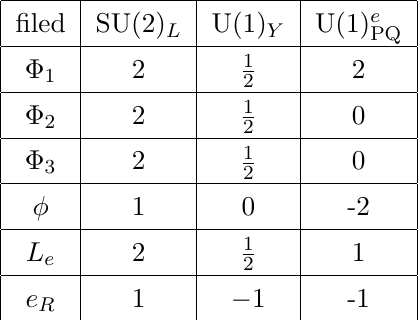
U(1) Y U(1) e , where U(1) e is a global Peccei-Quinn-like PQ PQ (cid:2) (cid:2)